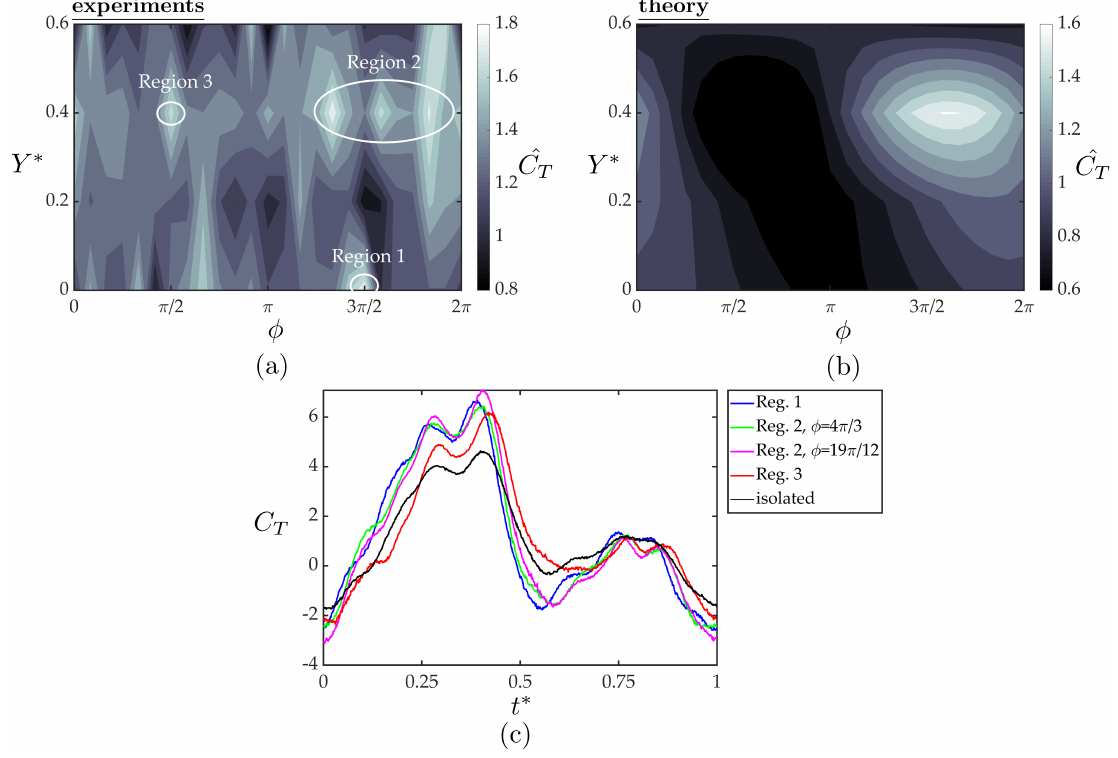
Figure 10. Normalized thrust coefficients of the follower hydrofoil acquired from the experiments ( a ) and the theoretical solution ( b ) as a function of cross stream spacing and synchrony. Three high thrust regions are denoted on the experimental data with white circles. The temporal variation of thrust coefficient within one oscillation cycle for the marked peak thrust cases compared to isolated foil case are given in ( c ). For each case, instantaneous thrust forces were phase averaged over 100 oscillation